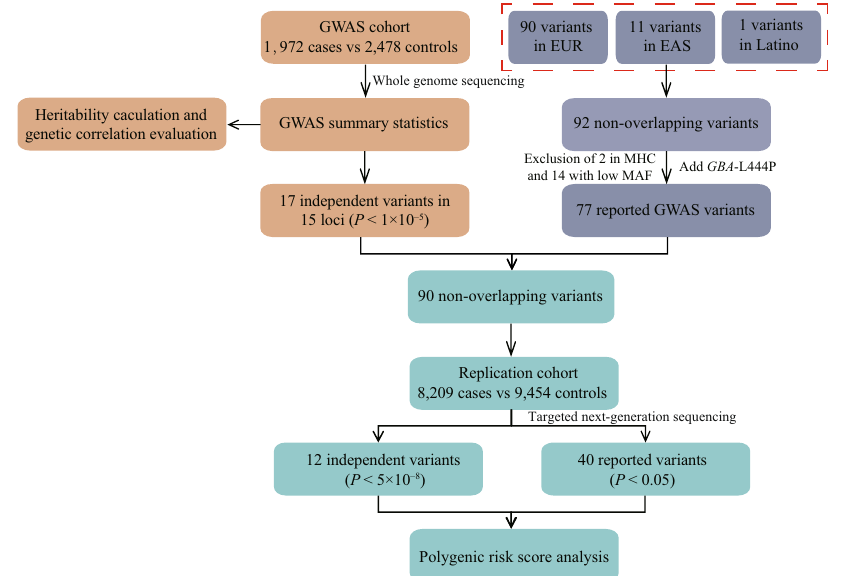
Fig. 1 Work fl ow of the study. EUR European, EAS East Asian, MHC histocompatibility complex region, MAF minor allele heritability of PD, assessed its genetic correlation with other traits, and established a predictive model to evaluate at-risk individuals in the Chinese population.